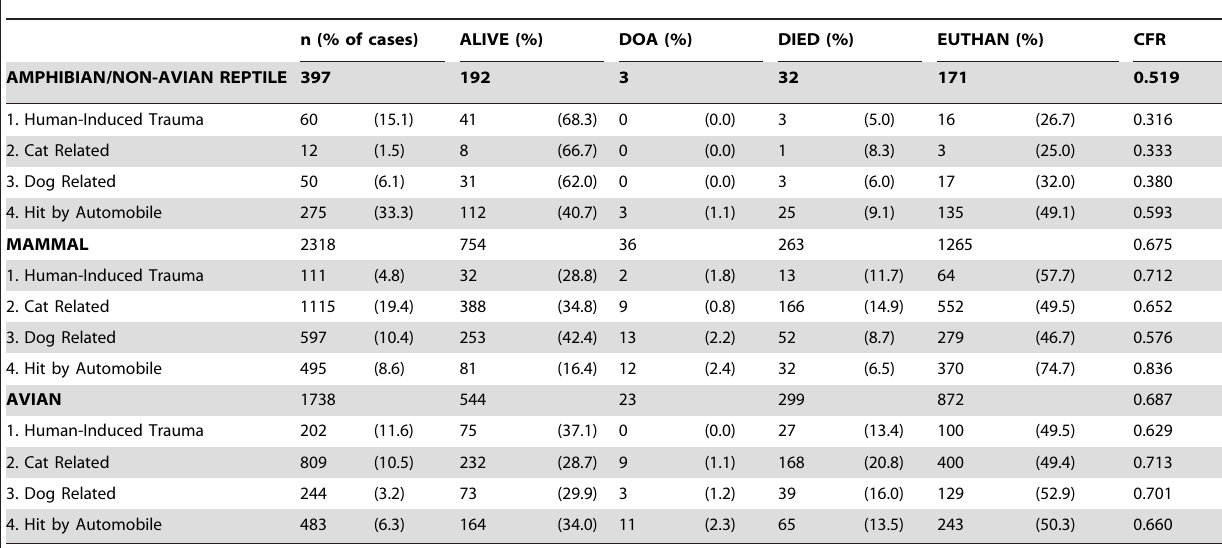
Table 1. Case outcomes and case fatality risks (CFR) for human-induced trauma, cat related, dog related, and hit by automobile cases for amphibian/non-avian reptile, mammal, and avian animals presented to a wildlife clinic in East